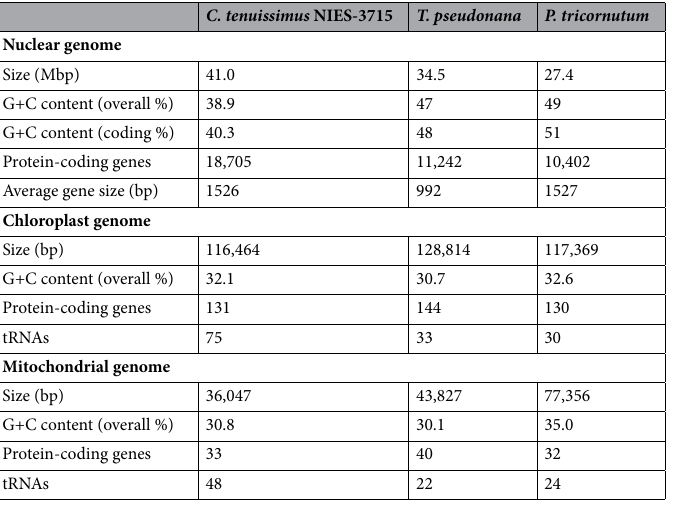
Table 1. Summary of genome